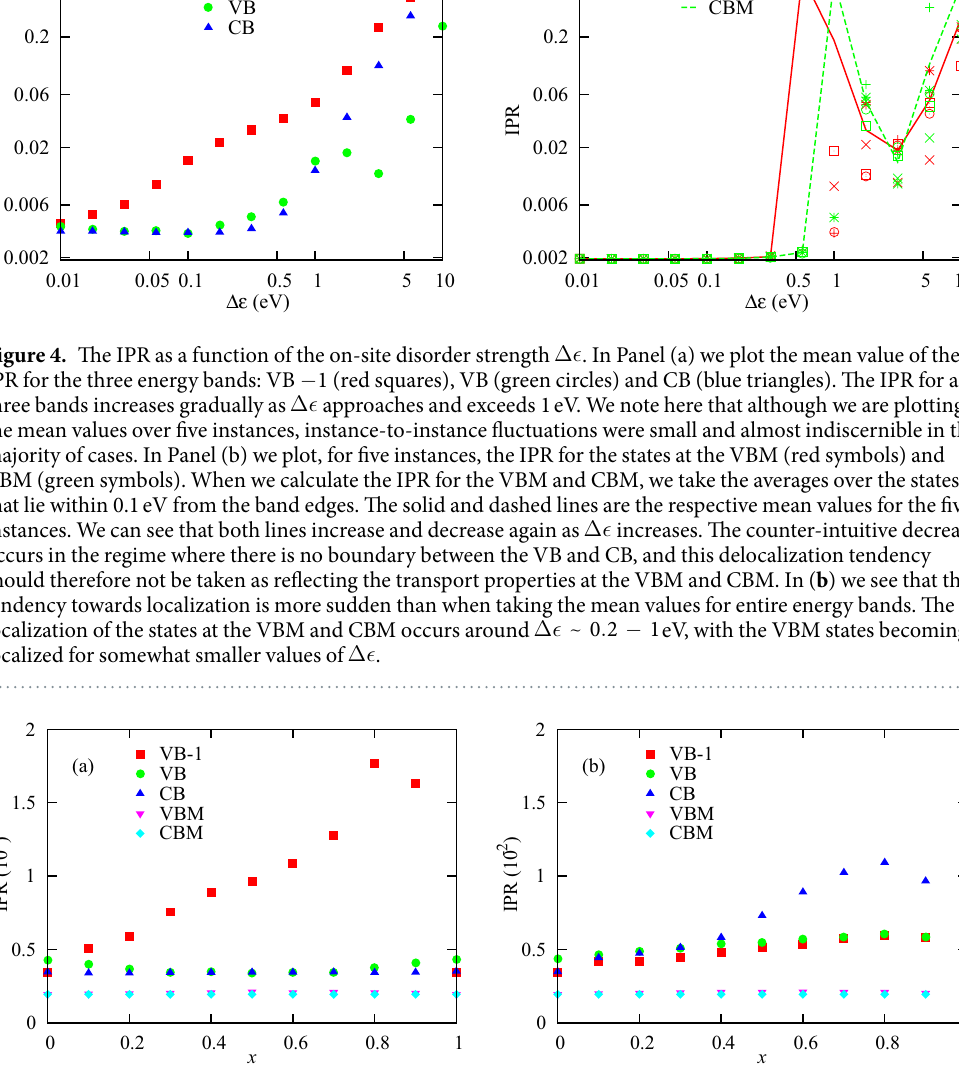
Figure 5. The IPR as a function of Br concentration x . Panels (a) and (b) correspond, respectively, to the models where the orbital energies and hopping strengths are modified when an I atom is replaced by a Br atom. The different data sets correspond to the mean values of the IPR over the VB − 1 (red squares), VB (green circles) and the CB (blue triangles), as well as the IPR values for for VBM (magenta inverted triangles) and CBM (cyan